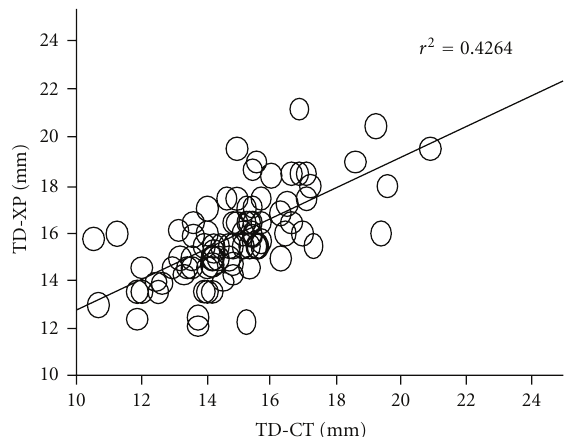
Figure 2: Correlation between TD-XP and TD-CT in female.